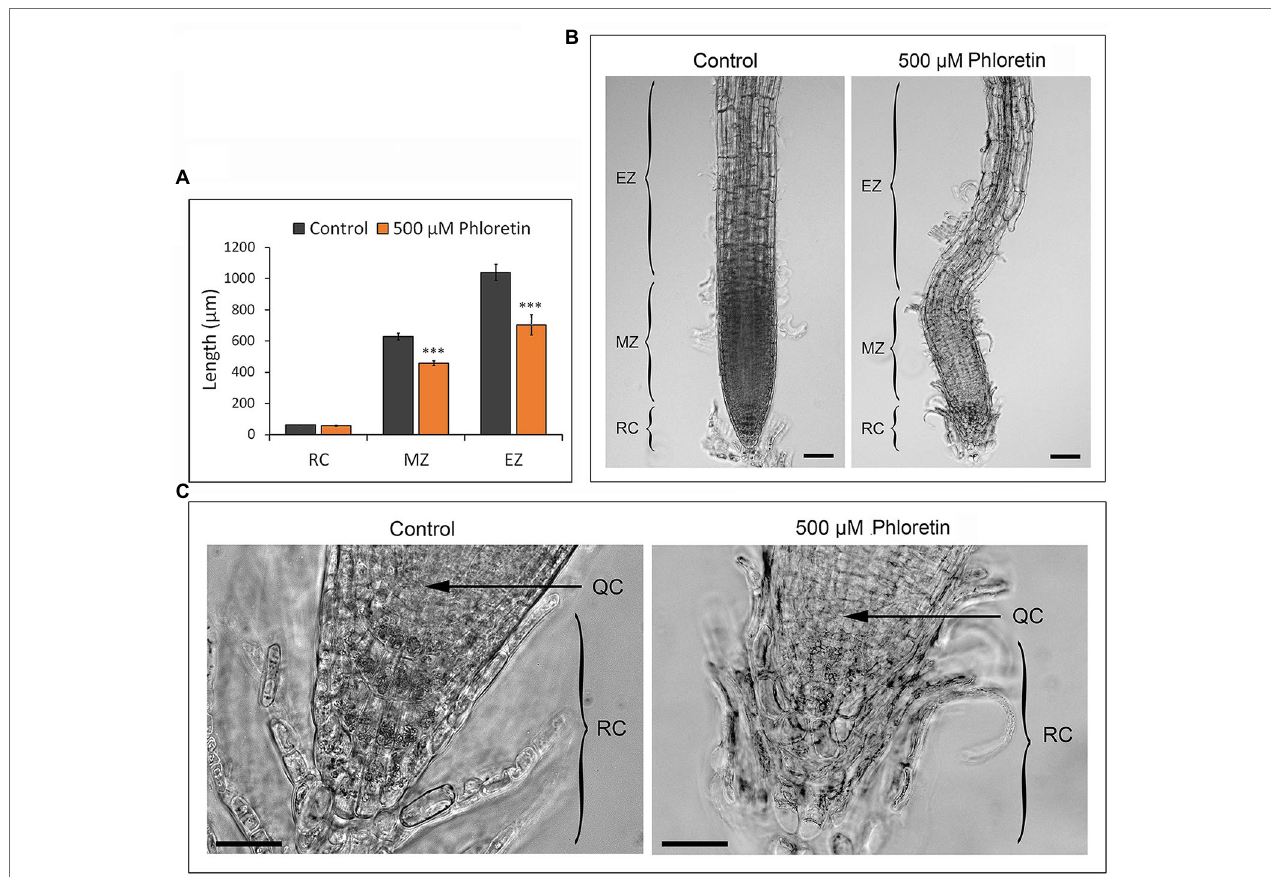
FIGURE 5 | Phloretin reduces the length of the root meristematic and elongation zones and disturbs root architecture in Arabidopsis. (A) Length of root cap, meristematic and elongation zone of 5 d after germination (DAG)-old seedlings vertically grown on control or 500 μ M phloretin-enriched medium. Values are presented as means ±SE of 20 seedlings (10 from each of two independent experiments). Asterisks indicate statistically significant difference at *** , p < 0.001 based on Student’s t -test. (B) Root architecture; Bar, 50 μ m, and (C) root apex architecture of 10 DAG-old seedlings vertically grown on control or 500 μ M phloretin-enriched medium; Bar, 25 μ m. Arrows indicate QC. Elongation zone (EZ); meristematic zone (MZ); root cap (RC); quiescent center (QC). The representative images are shown out of two independent